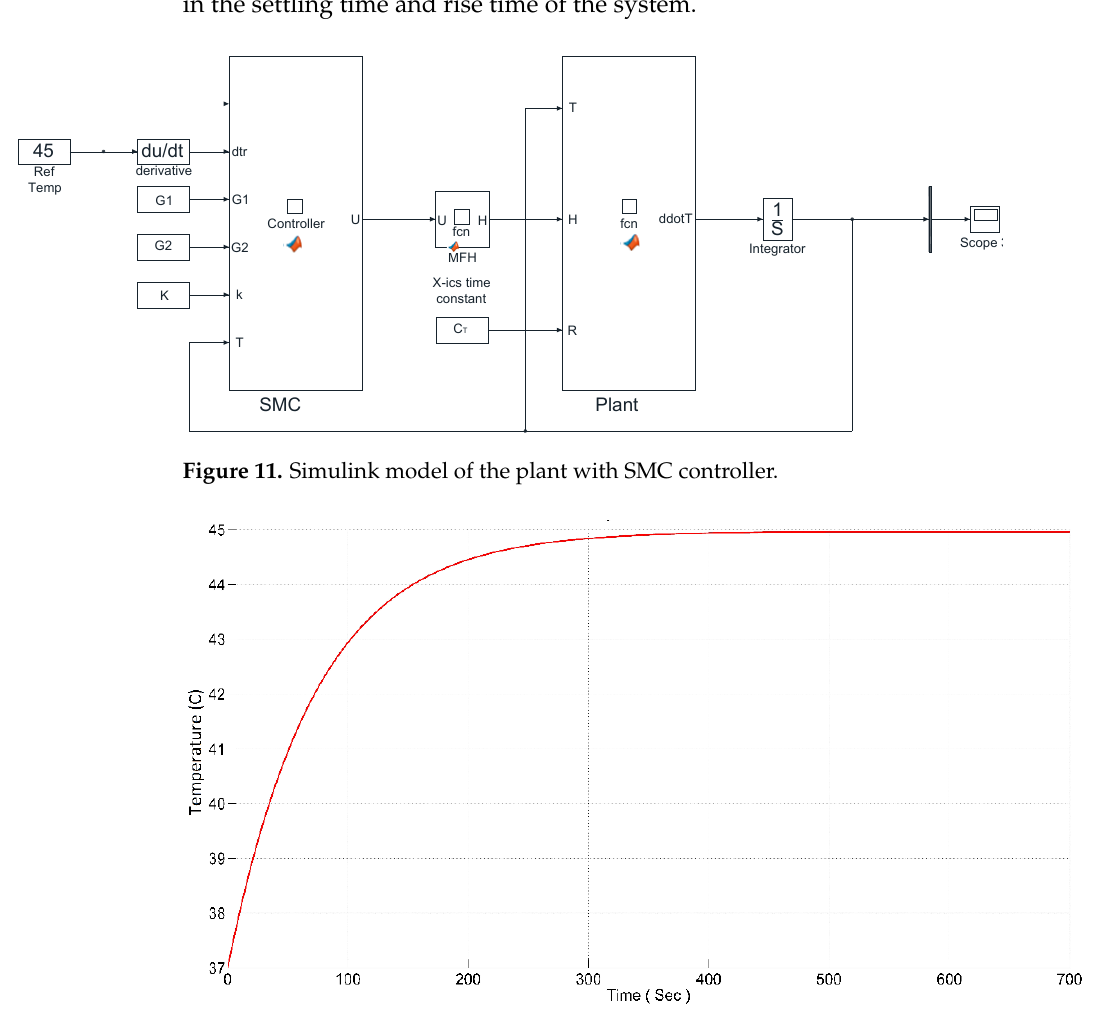
Figure 12. Step response of the plant with SMC controller.